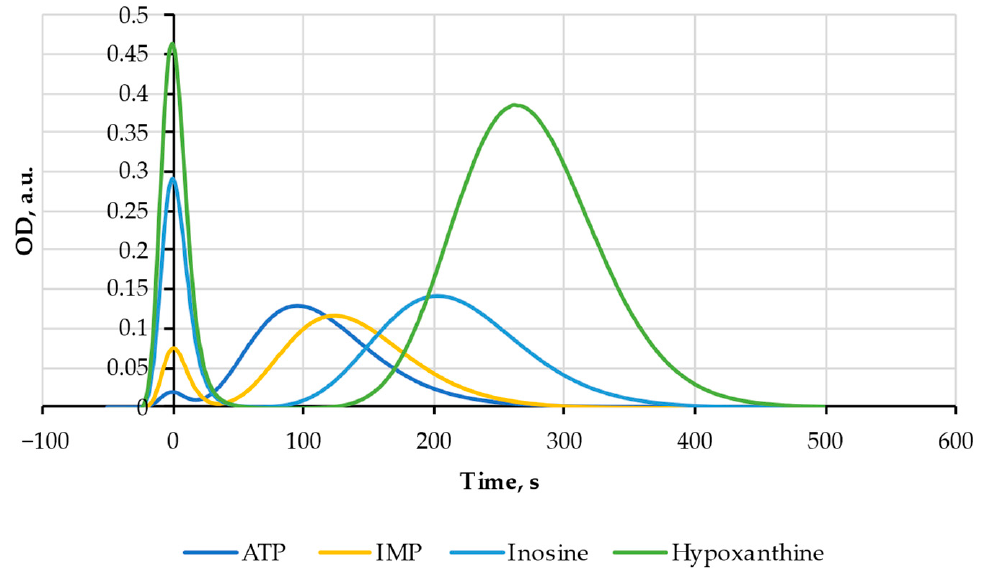
Figure 4. FPLMC sensor calibration with BSA and the nutritional nucleotides and nucleosides stand- ards. Table 1. Elution times of the main nutritional nucleotides and nucleosides.